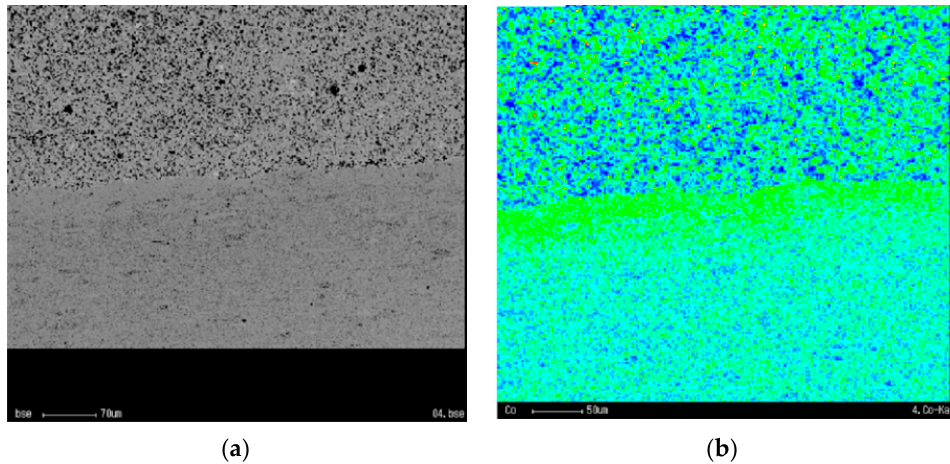
Figure 17. Microstructure of the interface in nanocrystalline and coarse WC-10Co powders: ( a ) SEM image; ( b ) cobalt mapping showing a 15 μ m thin layer with a higher cobalt content of about 14 wt.%. Reprinted with permission from ref. [125] Copyright 2008 Elsevier.